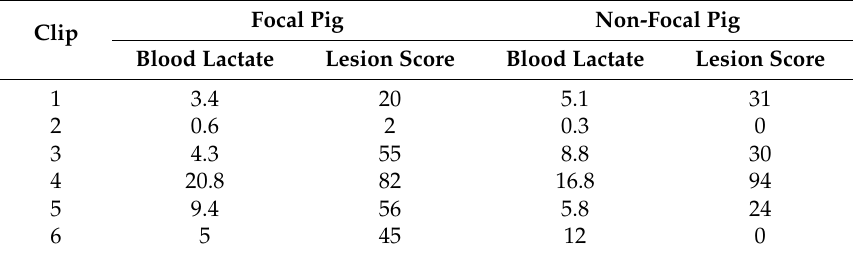
Table 3. Exact measures of relative change in lesion score (number of lesions per pig) and blood lactate (mmol/L) following the fight, compared to before the fight, for the pigs in each video clip.